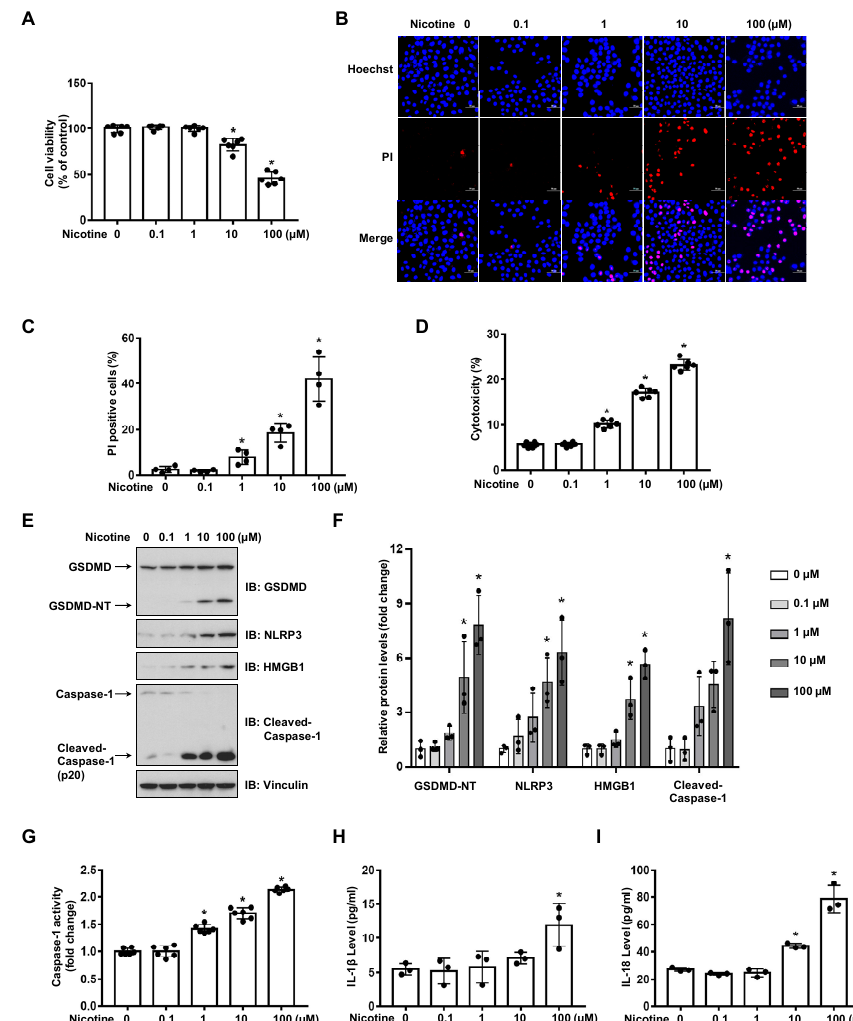
Figure 1. Nicotine induces pyroptosis in hepatocytes. LO2 cells were treated with nicotine at the indicated concentrations for 24 h. ( A ) Cell viability was detected by CCK-8 assay following exposure to nicotine ( n = 6). ( B , C ) Hoechst 33342/PI staining, fluorescence imaging ( B ) was acquired by confocal microscopy. Scale bar: 50 µ m. The percentage of PI-positive cells ( C ) was analyzed by using ImageJ software ( n = 4). ( D ) Cytotoxicity was determined by LDH release assay following exposure to nicotine ( n = 6). ( E ) The proteins levels of GSDMD, NLRP3, HMGB1 and Cleaved-Caspase-1 was measured by using Western blotting. ( F ) Quantification of GSDMD-NT, NLRP3, HMGB1 and Cleaved-Caspase-1 levels as in ( E ) ( n = 3). ( G ) The activity of Caspase-1 was determined by using Caspase-1 activity assay kit ( n = 6). ( H , I ) The concentrations of IL-1 β ( H ) and IL-18 ( I ) in the conditioned medium were determined by ELISA ( n = 6). Data shown represent the mean ± SD (*, p < 0.05).